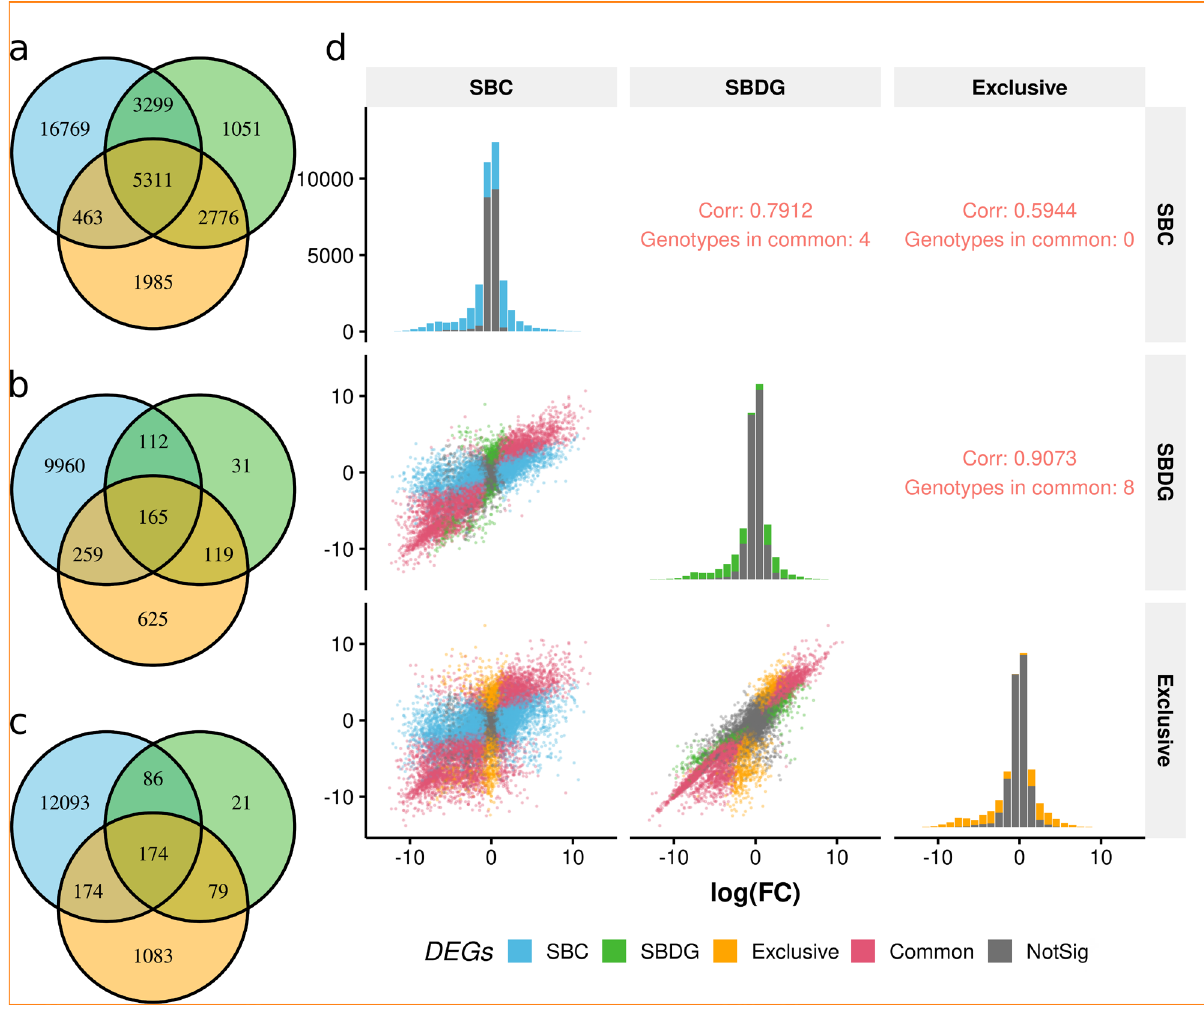
Figure 5 – Differentially expressed genes shared by three sets of samples: SBC, SBDG, and SBDG-exclusive genotypes. The method for filtering genes with low expression was the same for the three sets, adopting a more permissive criterion due to the lower number of samples in the exclusive set (CPM > 1 for at least two samples). We only considered the genes passing the low expression filtering criterion in all sets (38,420 genes). The diagrams represent contrasts VLB × HB.LB.VHB ( a ), VHB × HB.LB ( b ), and HB × LB ( c ). Correlation of log fold changes among the two strategies and the set of SBDG-exclusive samples, for contrast VLB × VHB.HB.LB ( d ). In the main diagonal, the histograms show how the distribution of differentially expressed genes (DEGs) and non-DEGs, as a function of the log fold change (logFC). The classification of genes considered the result of